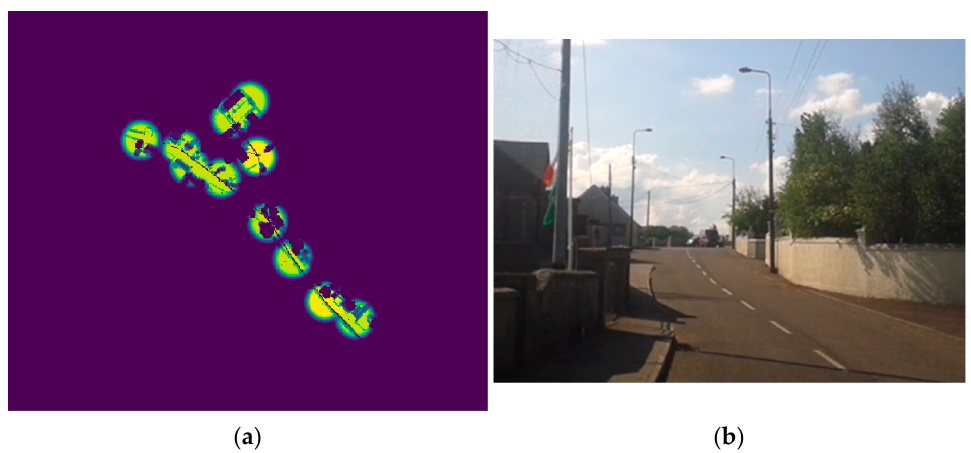
Figure 2. ( a ) False colour image of the town of Ballindangan, showing the effect of houses and trees on the expected emission towards the zenith. In this case, the fraction of diffuse light to the zenith was reduced by 70% due to the effect of obstructions. The image is approximately 450 metres on a side. ( b ) Photo of part of the street showing the relatively open nature of the environment.